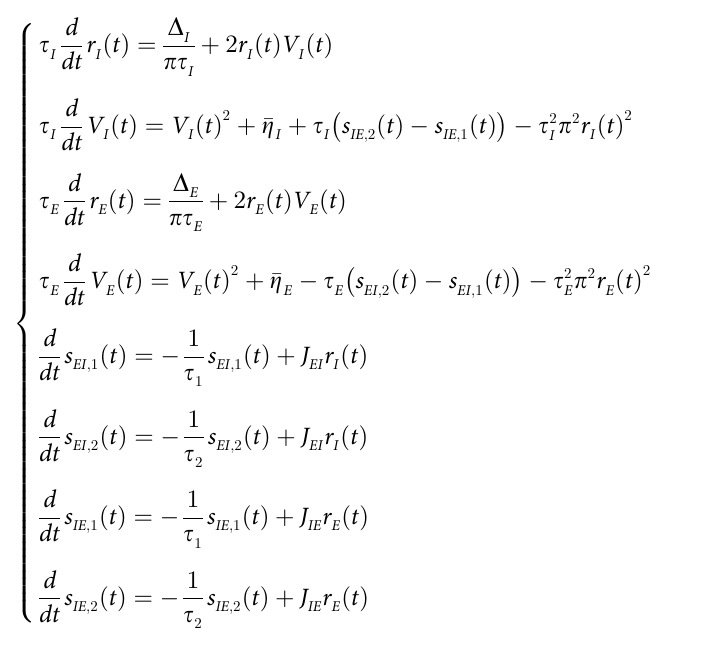
S1 Fig. Dependence of the phase dispersion on the heterogeneity of the bias current. The phase dispersion was determined as the time difference between the first and the last spike in